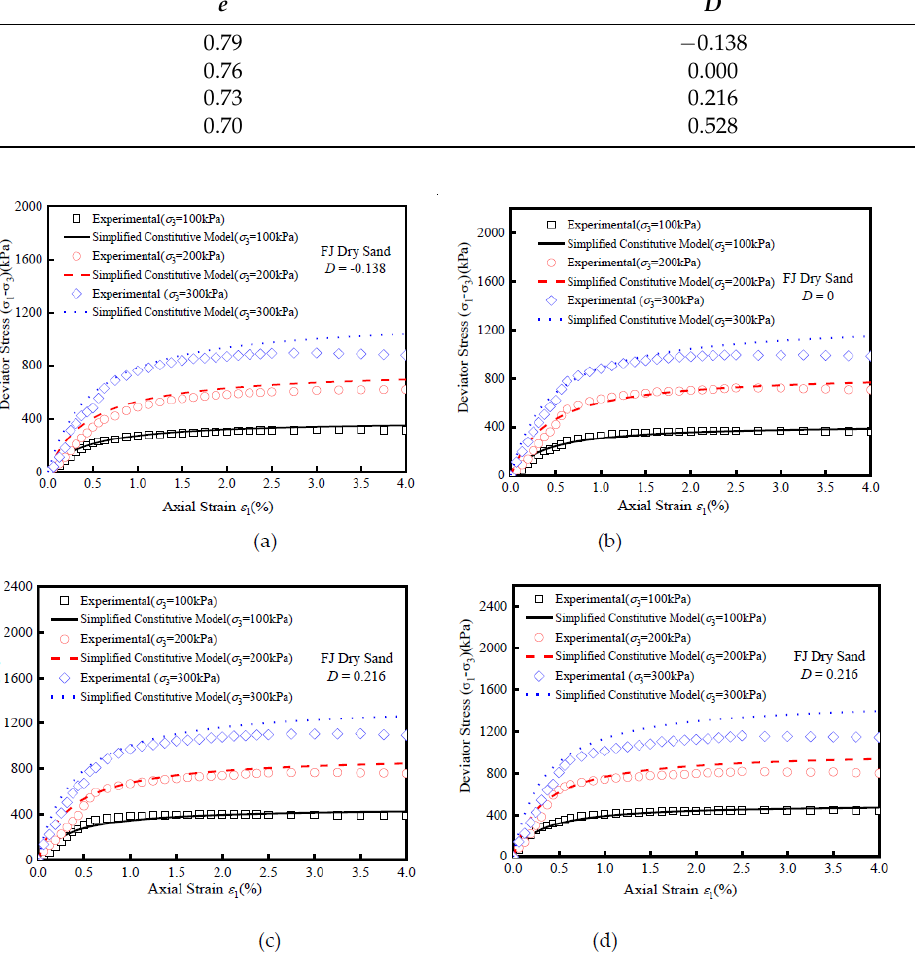
Figure 8. Theoretical and experimental stress–strain curves for the FJ dry sand. ( a ) D = − 0.318; ( b ) D = 0; ( c ) D = 0.216; ( d ) D =